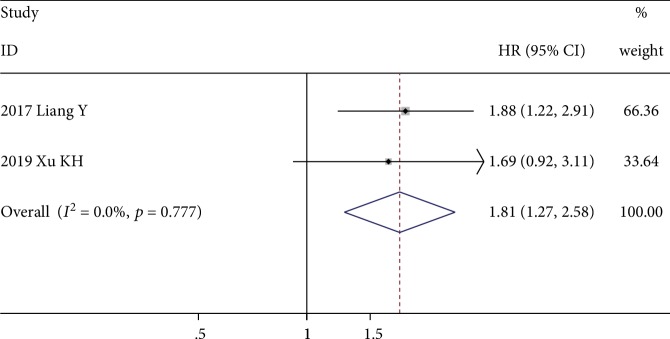
Forest plot showing the association between elevated CAR and DFS in patients with sarcoma. The pooled effect was calculated using a fixed-effects model.